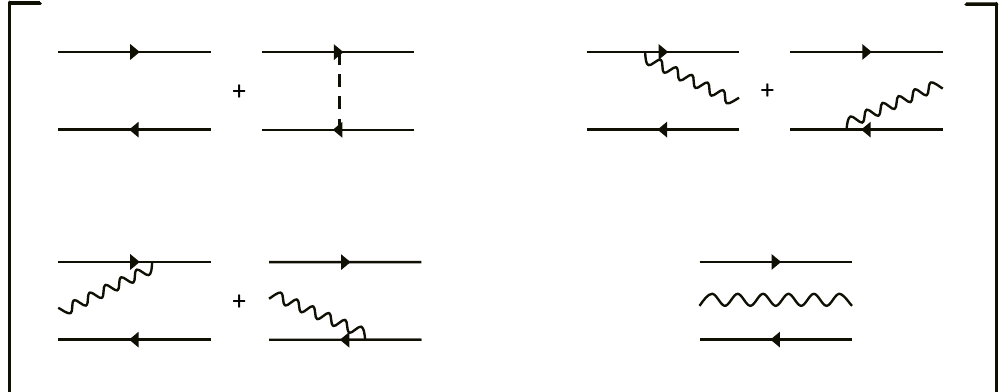
Figure 1 . The form of the Hamiltonian in the truncated Fock-space. The instantaneous Coulomb exchange is shown by the dashed line. Each diagram has one insertion of the Hamiltonian, with the sum over energy insertions in the top-left and bottom-right diagrams not shown